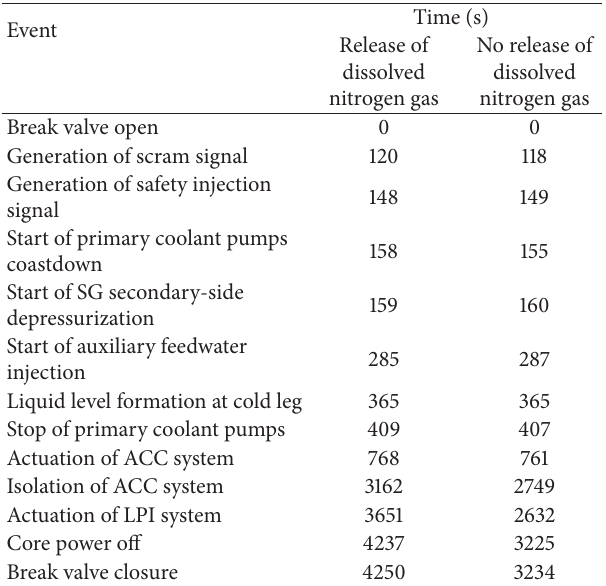
Table 3: Chronology of major events in LSTF tests with or without release of dissolved nitrogen